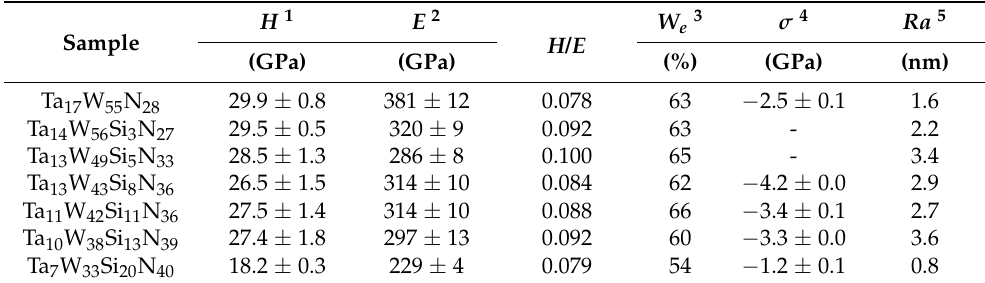
Table 2. Mechanical properties of the TaWSiN/Ta/Si